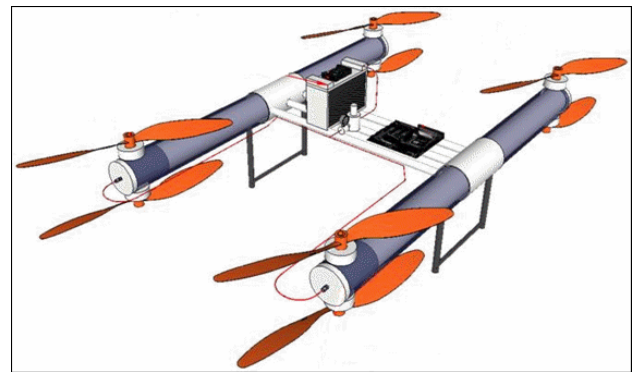
Figure 4. Scheme of the PEM fuel cell-based UAV.